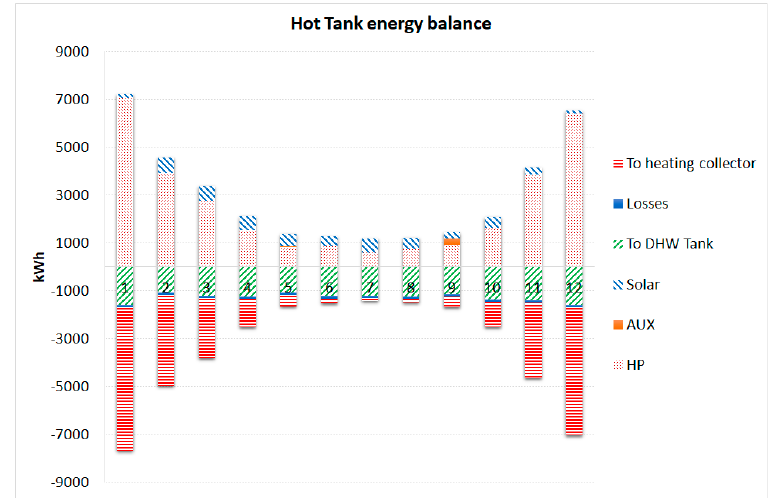
Figure 14. Energy balance for the hot tank for the A3 alternative.